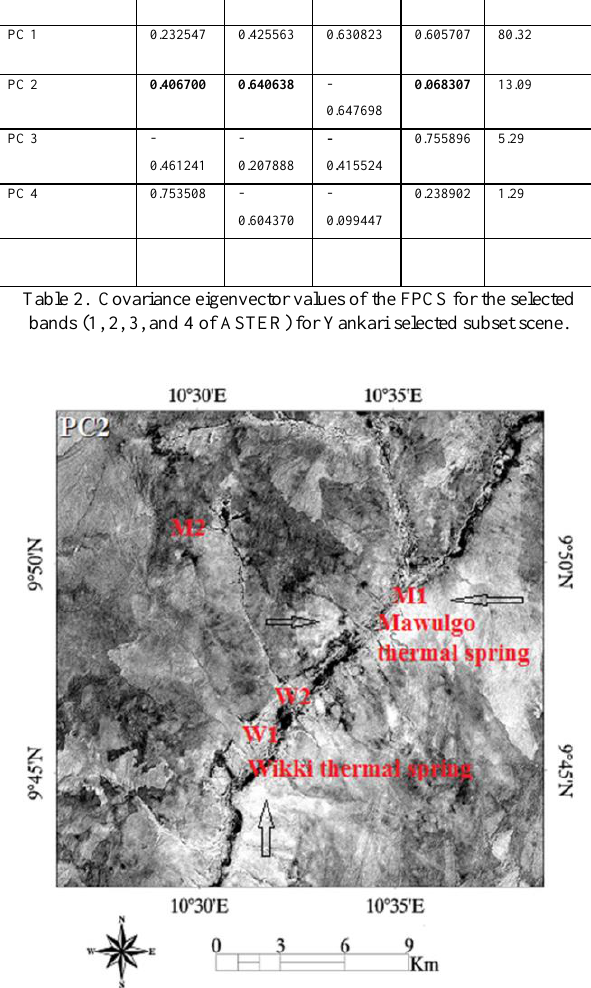
Figure 4. PC2 showing bright pixels as possible alteration zones due to iron oxide/hydroxide minerals.